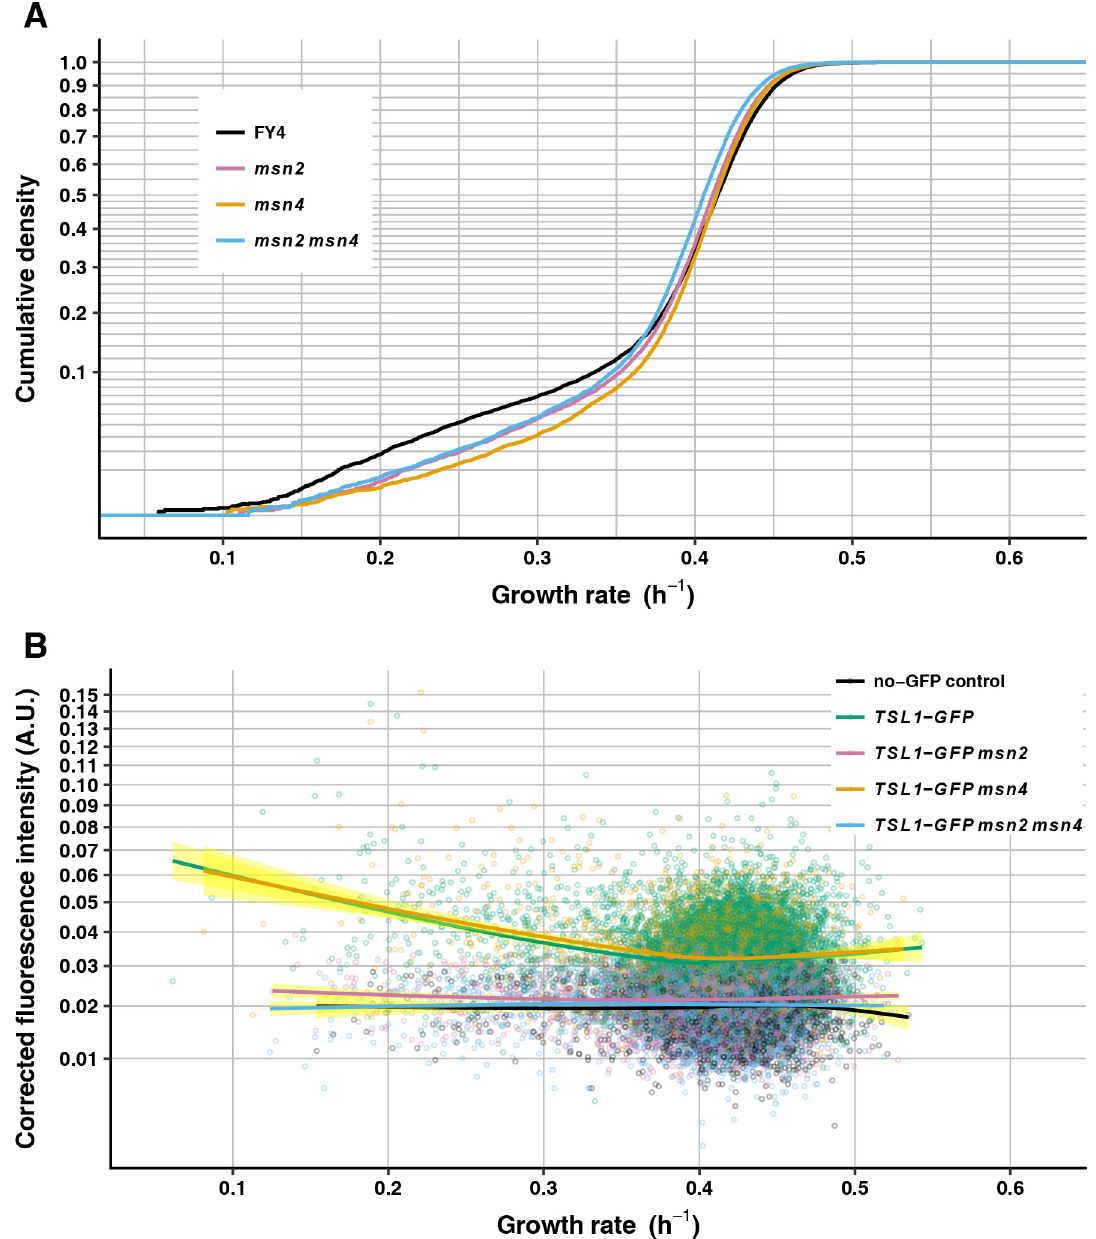
Fig 6. Msn2 and Msn4 are required for nongenetic heterogeneity. (A) Growth-rate cumulative density curves of FY4 (black, 14470 microcolonies), msn2 (light purple, 14899 microcolonies), msn4 (light orange, 11729 microcolonies) and msn2 msn4 (light blue, 11894 microcolonies). Vertical axis is on a square-root scale for a better view of the slower-growing tail of each distribution. (B) Mean GFP fluorescence intensity—corrected by subtracting local background fluorescence then by subtracting the minimum value for the entire experiment, to avoid negative values (see Methods, vertical axis)—is plotted against microcolony growth rate for FY4 no-GFP control (black, 3915 microcolonies), TSL1-GFP (green, 10531 microcolonies), TSL1-GFP msn2 (light purple, 6460 microcolonies), TSL1-GFP msn4 (light orange, 3724 microcolonies), and TSL1-GFP msn2 msn4 (light blue, 5621 microcolonies). Each solid line is the fit to a generalized additive model with cubic spline smoother, with 95% confidence interval shown in yellow. Vertical axis is on a square-root scale for a better view at the low-intensity